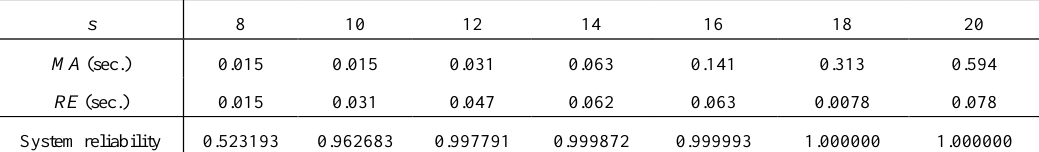
Table 2. Comparison of calculating time when m = 5, r = 4, n = 40000 and p = 0.